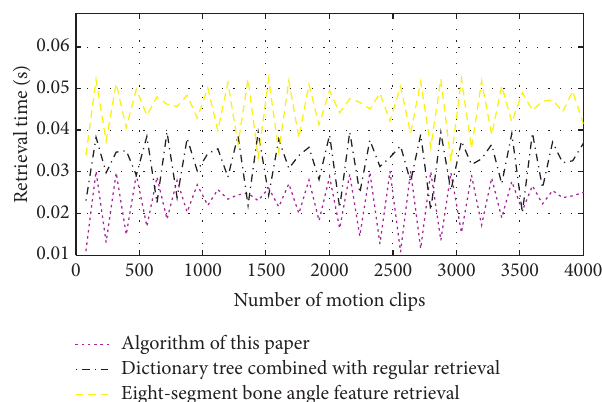
Dictionary tree combined with regular retrieval Eight-segment bone angle feature retrieval Figure 12: Retrieval time of various methods under different body motion database